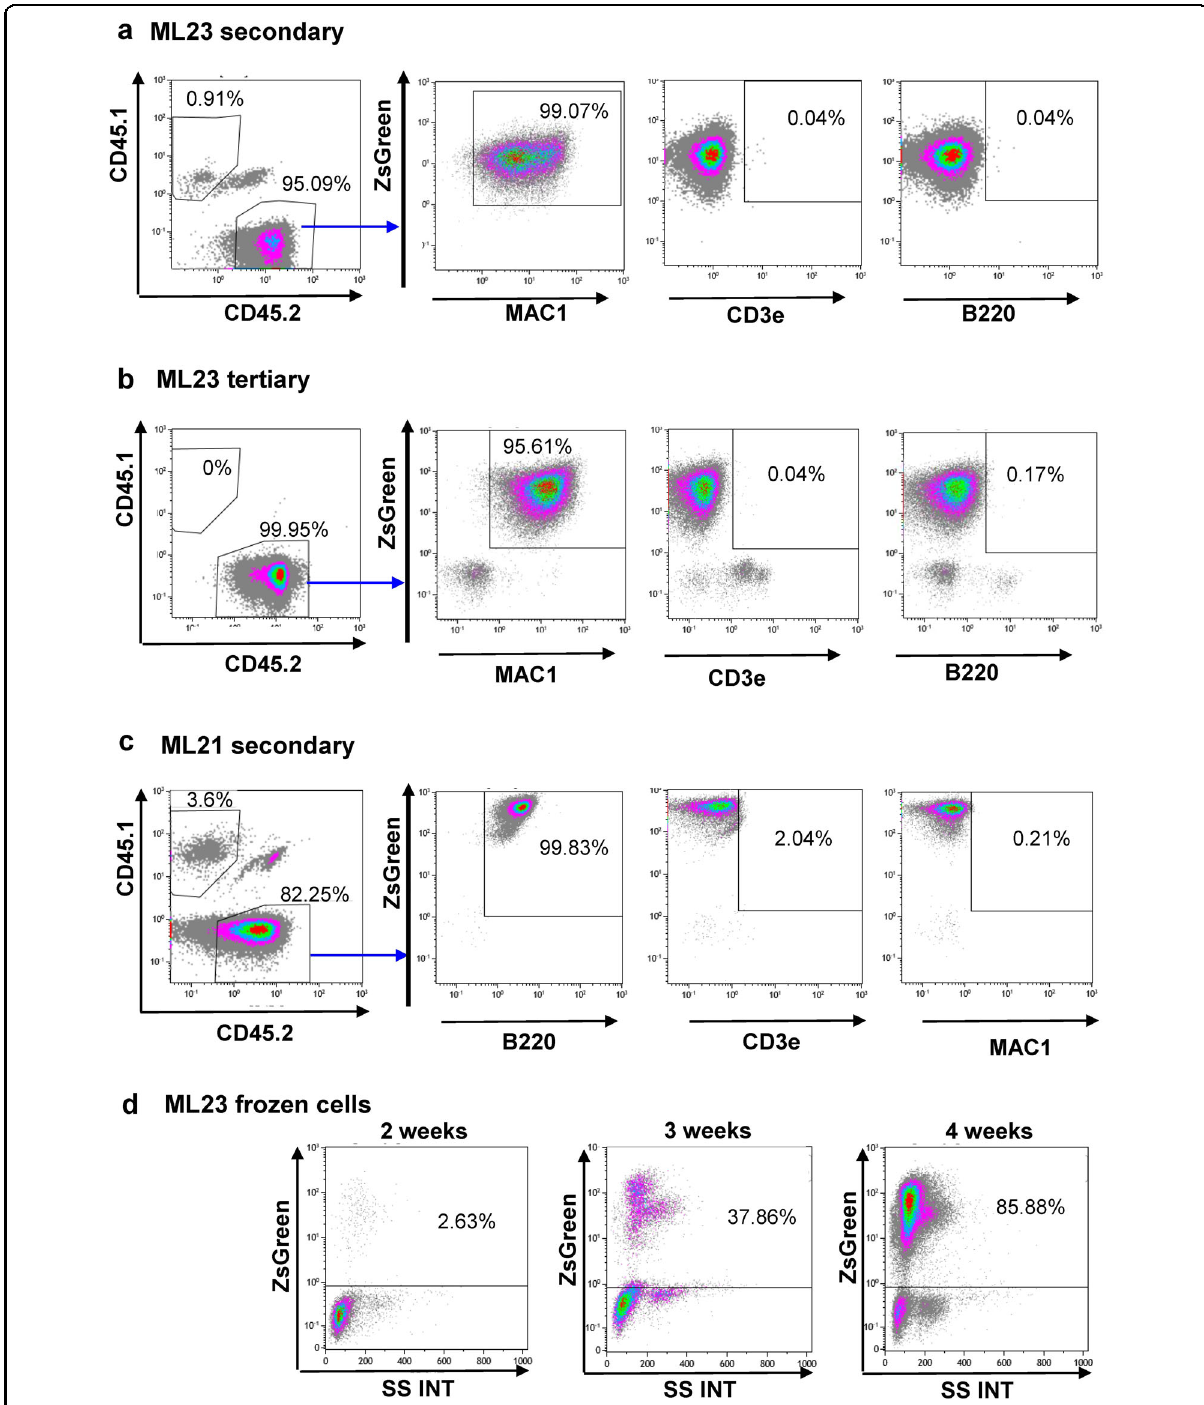
Fig. 2 Leukemia lines can passage into WT mice. Representative PB FACS taken from secondary recipient 30 days after passage of ML23 ( a ), tertiary ML23 recipient ( b ), or ML21 ( c ). One million fresh cells were used for these passages. Plots show frequencies of the transplanted CD45.2 cells, expression of ZsGreen reporter, Mac1, CD3e, and B220 staining. Data shown from one out of at least three independent experiments. d Representative PB FACS of recipient mice after transplantation with previously frozen ML23 cells. Data shown from one out of at least three independent